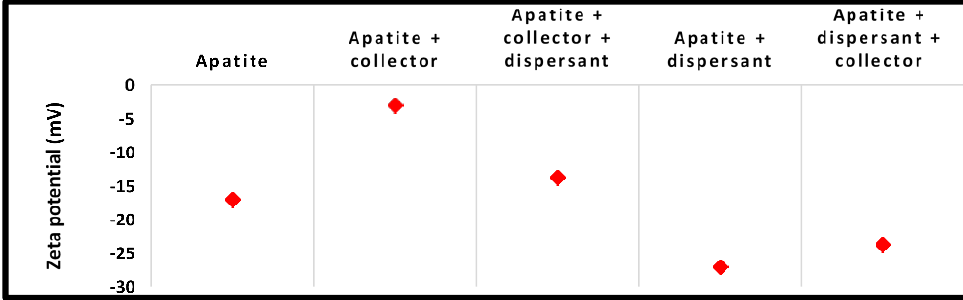
Figure 8. Zeta potential of apatite before and after mixing with flotation reagents at pH 9.